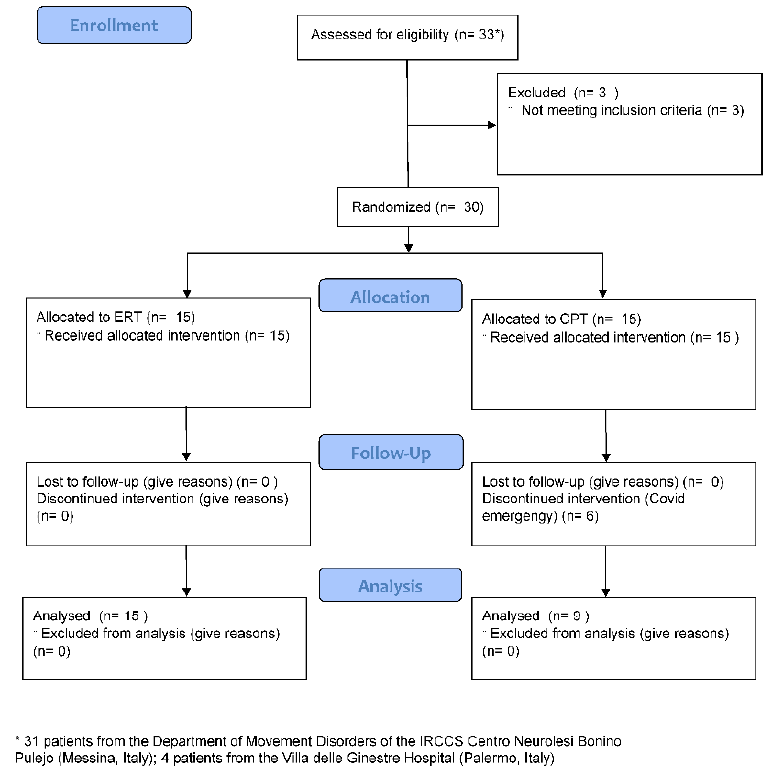
Figure 1. Patients’ diagram flow.